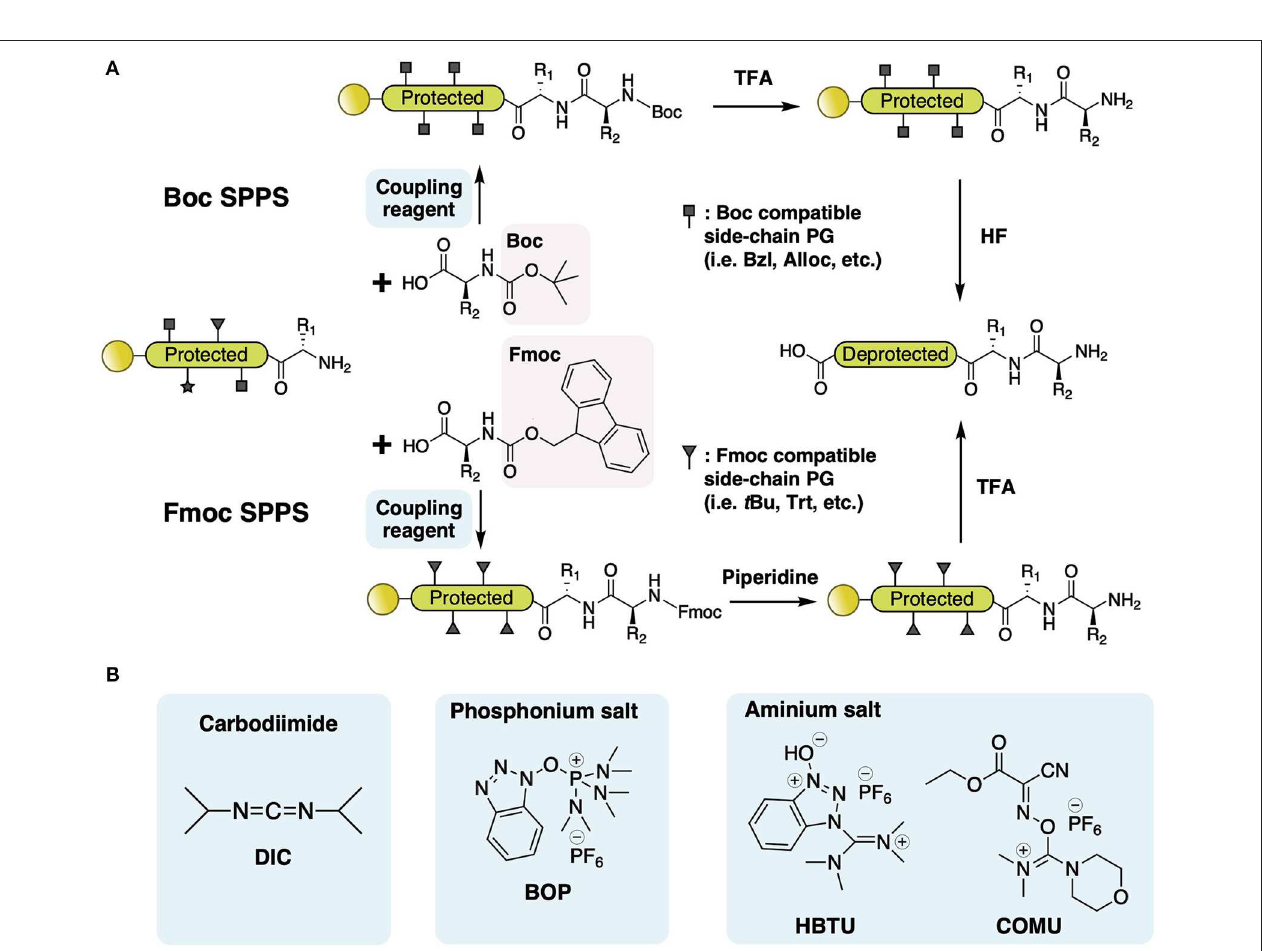
FIGURE 2 | (A) Comparison of Boc and Fmoc SPPS. Fmoc/ t Bu SPPS employs removal of the amine-protecting Fmoc group in an alkaline condition (normally 20% piperidine) and eventual cleavage of orthogonal side-chain protecting groups, including t Bu and the support linker, by high-percentage TFA, whereas Boc/bzl SPPS requires harsher reaction conditions, using 50% TFA for amine-protecting Boc removal and 90% HF for protecting groups and support linker cleavage. (B) Examples of three classes of coupling reagent, carbodiimides, phosphonium salts, and aminium